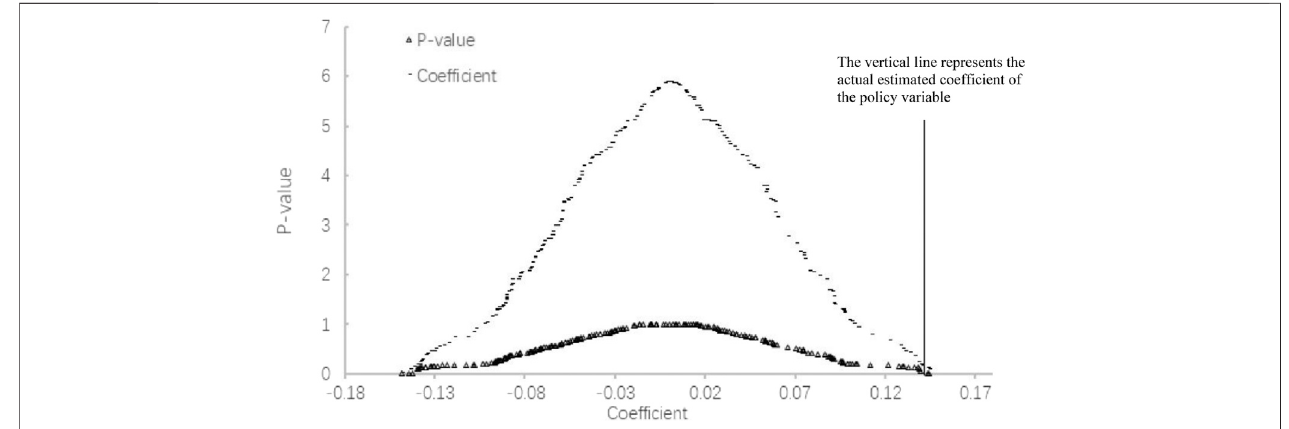
FIGURE 6 | Placebo test for the